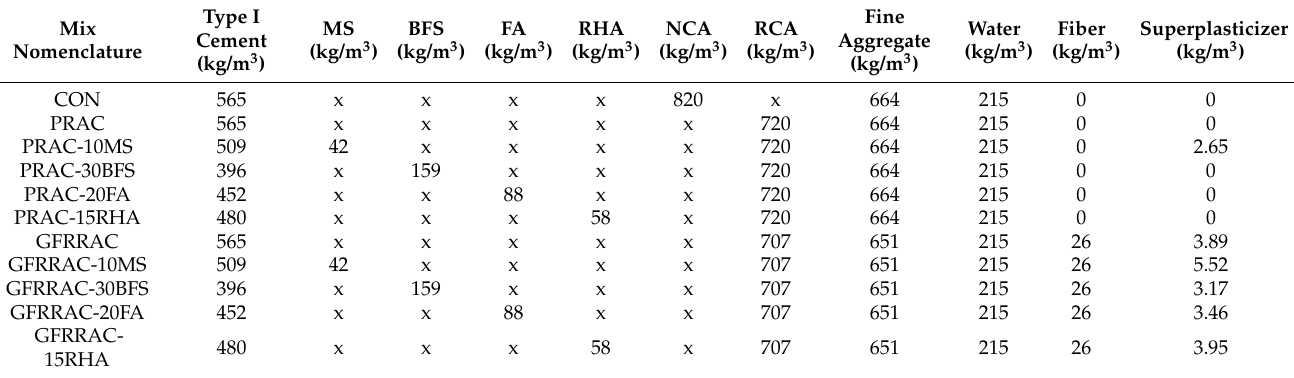
Table 4. Details of mix